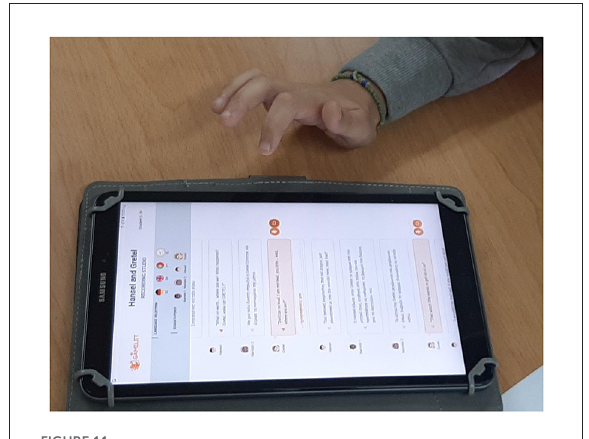
FIGURE11 Student working with the digital version of the Recording Studio